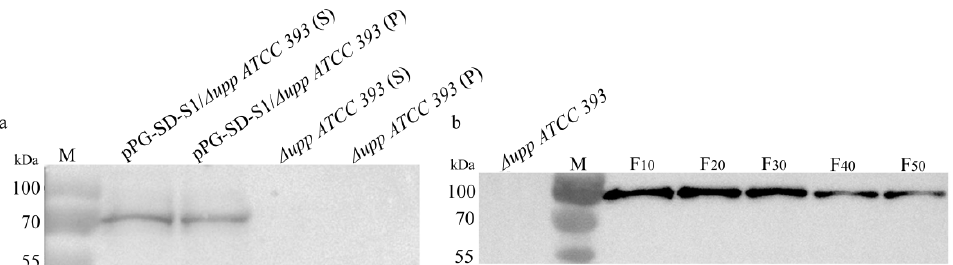
Figure 3. The expression and stability of the target protein was identified in Western blots using a mouse anti-S1 monoclonal antibody ( a , b ). pPG-SD-S1 / Δ upp ATCC 393 lysate supernatant [pPG-SD-S1 / Δ upp ATCC393 (S)] and pellet [pPG-SD-S1 / Δ upp ATCC393 (P)] show relevant immunoreactive bands, but the supernatant ( Δ upp ATCC393 (S)) and pellet ( Δ upp ATCC393 (P)) of Δ upp ATCC 393 lysate do not. The relevant immunoreactive bands are evident in the pPG-SD-S1 / Δ upp ATCC 393 lysate from the 10th to 50th generations, but not in Δ upp ATCC 393 . M: protein molecular weight marker.